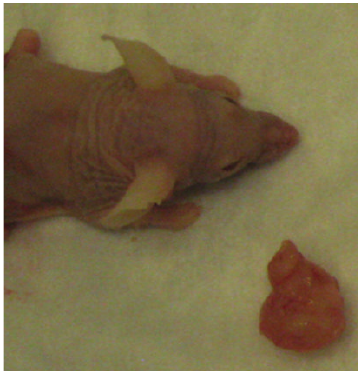
Figure 7: Example of a subcutaneous tumor derived from the 12-KOSR-Xn-89 reprogrammed cells. The photographed tumor (bottom right corner) was excised six months after subcutaneous injection of 5 × 10 6 cells. A recipient mouse is shown for